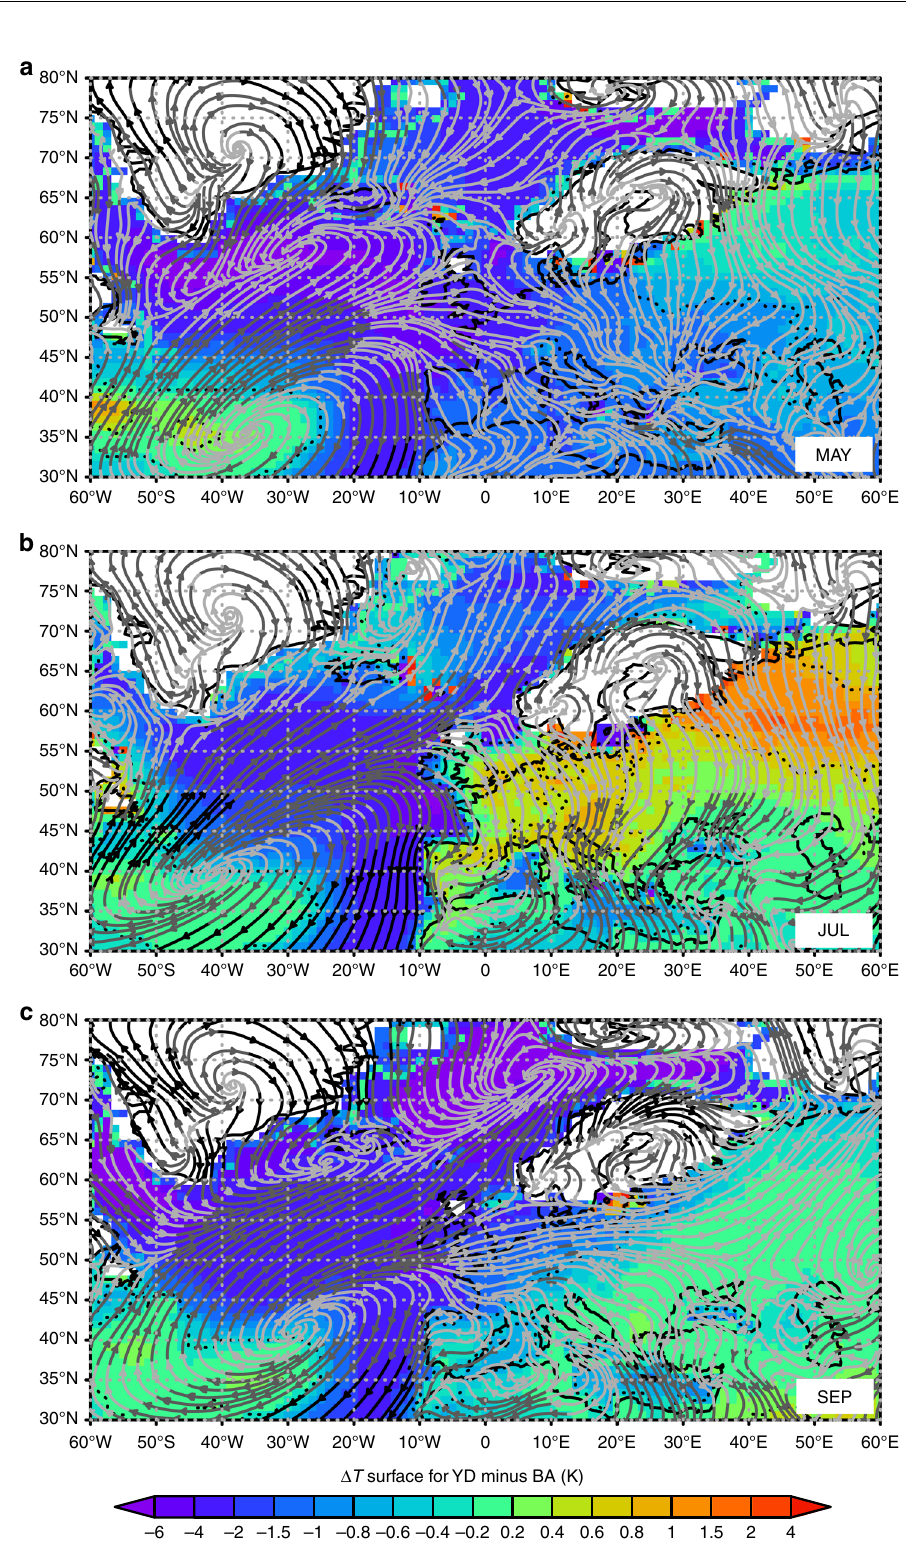
Fig. 3 Simulated link between YD-BA temperature changes and mean atmospheric fl ow during the YD. Simulated changes in monthly mean surface temperatures of YD minus BA (K) with CESM1 for a May, b July and c September (shaded colours). May and September show a strong cooling from W to E-Europe which is in contrast to the warm but very short summer season. Stream lines represent the monthly mean wind patterns during the YD which highlight the cooling by zonal advection in May and September from the cold North Atlantic towards Europe which is absent during